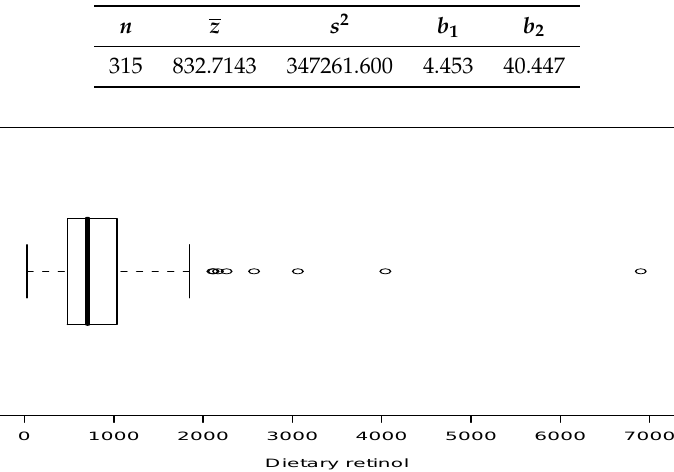
Table 5. Summary statistics for the dietary retinol concentration.